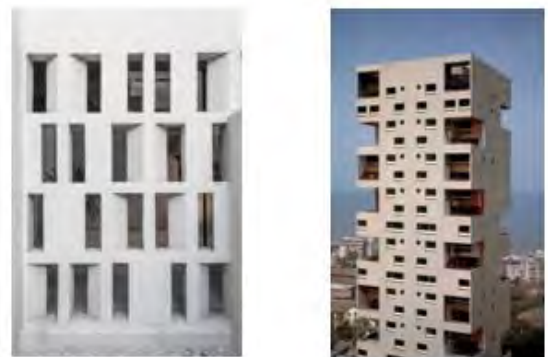
Figure 10. Small Windows Facades